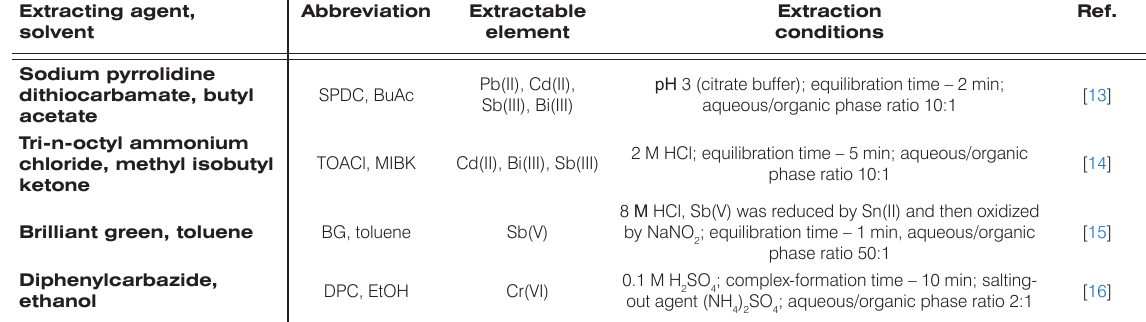
Table 1. Extraction systems for hyphenated ETAAS